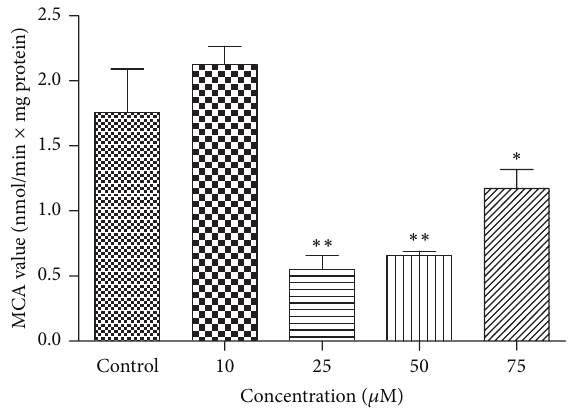
Figure 6: Determination of proteasome activity after quercetin treatment of B-CPAP cells. The fluorogenic peptide suc-LLVY- MCA was used as substrate to measure chymotrypsin-like (CT-L) activities of 20S and 26S proteasome. Differences between means and significance of the treatments were analyzed using ANOVA and Bonferroni posttest. Bar graphs represent mean ± SD, 𝑛 = 3 . ∗ 𝑝 < 0.05 versus control, ∗∗ 𝑝 < 0.01 versus